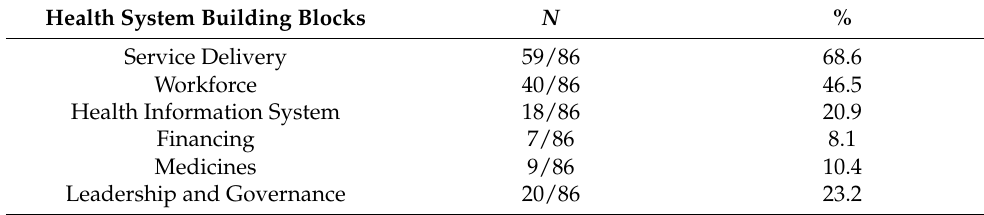
Table 2. Nature of the health system building blocks addressed in the selected